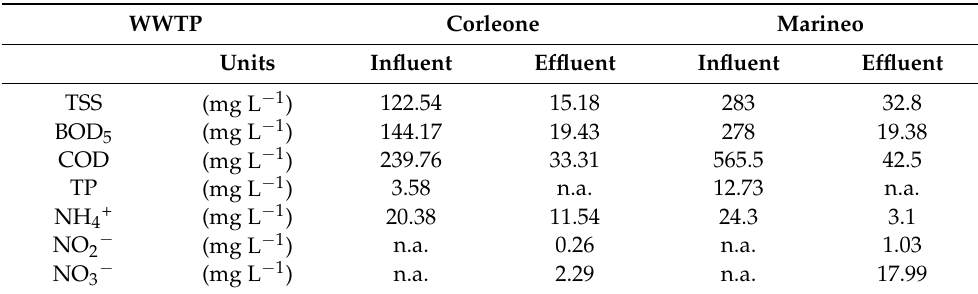
Table 1. Inlet and outlet average values of the main quality parameters for the Corleone and Marineo WWTPs.